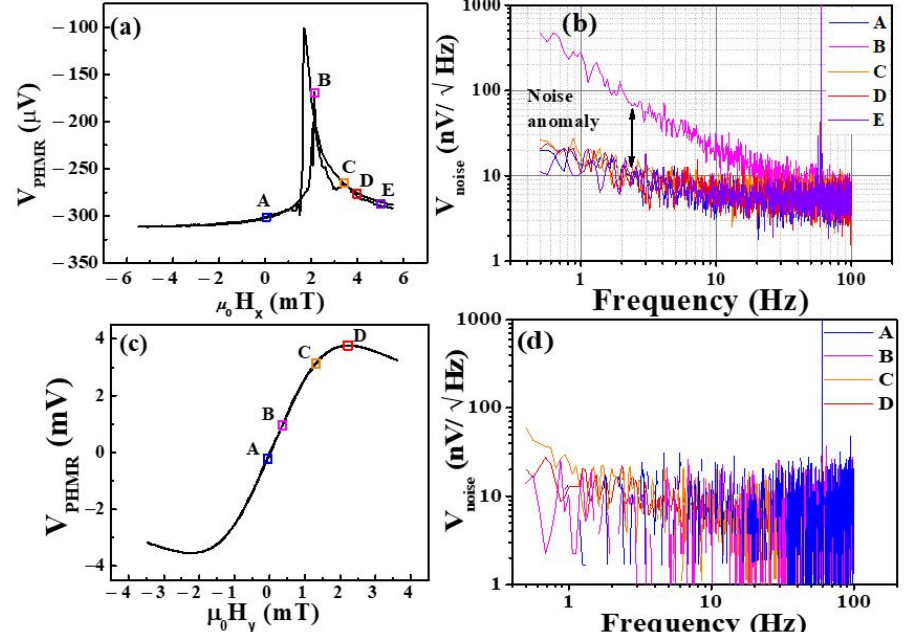
Figure 10. ( a ) V PHMR - H x curve of the tri-mPHMR device. ( b ) Noise voltage spectra of the tri-mPHMR sensor when the external field was applied in parallel to the sensor easy axis (along x -axis). ( c ) V PHMR - H y curve of the tri-mPHMR device. ( d ) Noise voltage spectra of the tri-mPHMR sensor when the external field was applied transversely to the sensor easy axis (along y -axis). All measurements were performed at room temperature, and the sensing current was set to 1